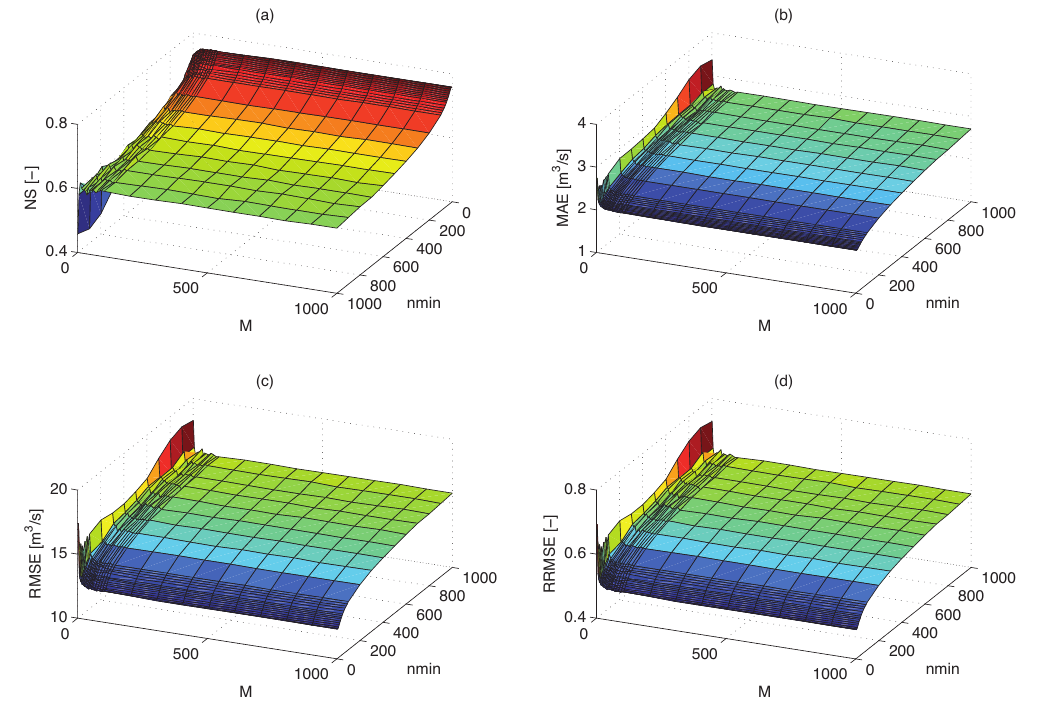
Fig. 2. Values of NS (a) , MAE (b) , RMSE (c) and RRMSE (d) as a function of n min and M over the testing subsets for Marina Catchment (average over 10 data